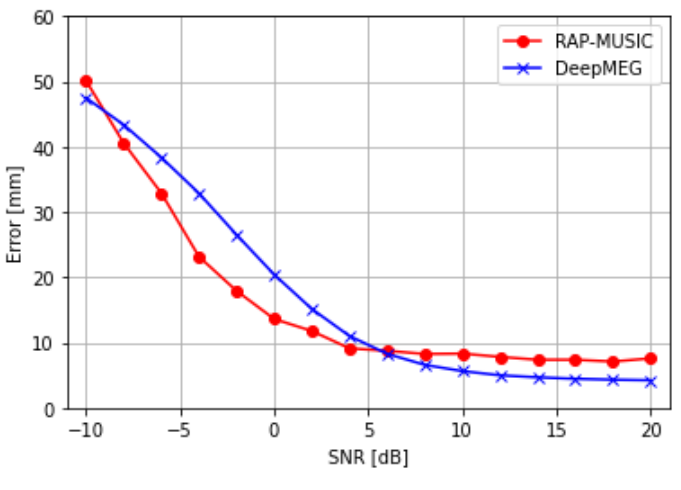
Figure 5. Localization accuracy of the DeepMEG-MLP model at different SNR levels for the cases of two dipole